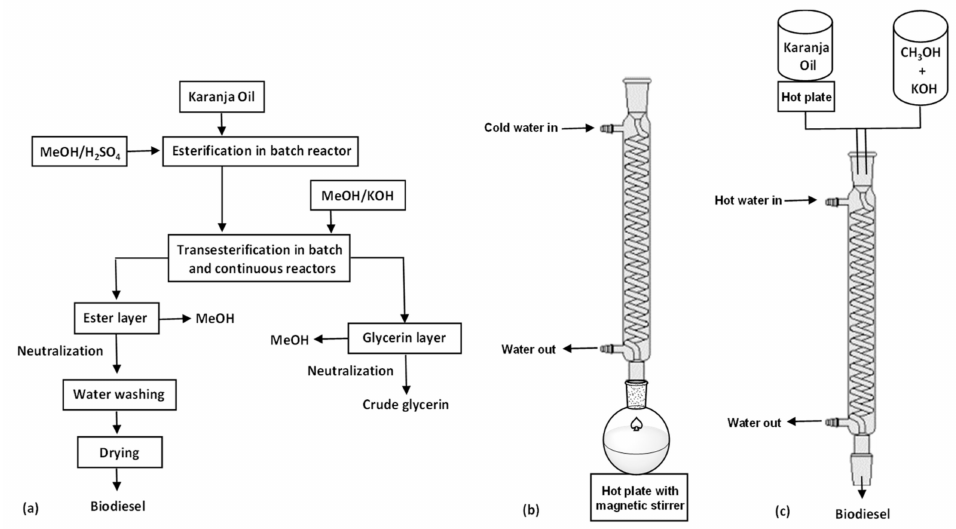
Figure 16. ( a ) Process for biodiesel production; ( b ) batch reactor; ( c ) helical tube reactor. The continuous experimental conditions were a reaction temperature of 65 ◦ C, a reaction time of 1 h, a methanol/oil molar ratio of 5:1, 0.8% ( w / w ) of KOH as catalyst and a flow rate of 6.6 mL/min, with a maximum biodiesel yield of 96.6%. The residence times in the helical tube reactor and RD column were 4 and 8 min,